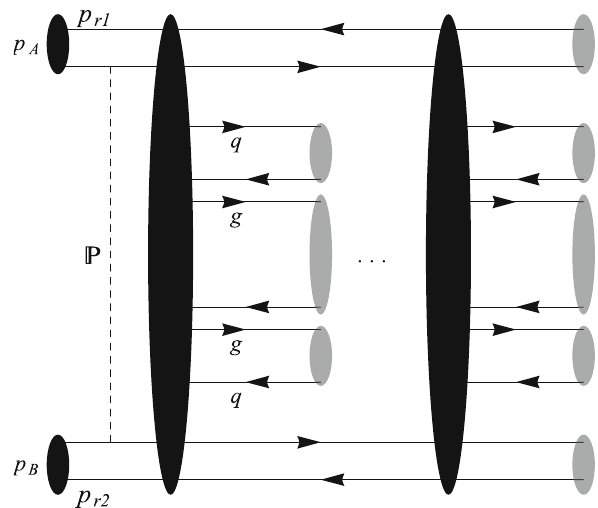
Fig. 6 Colour structure of soft particles produced with the new model for soft interactions, shown in the context of a complete hadron–hadron